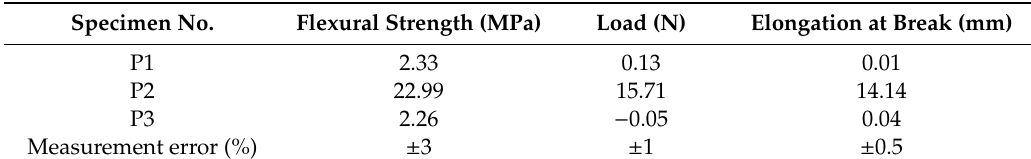
Table 7. Flexural tests for method 5 specimens.